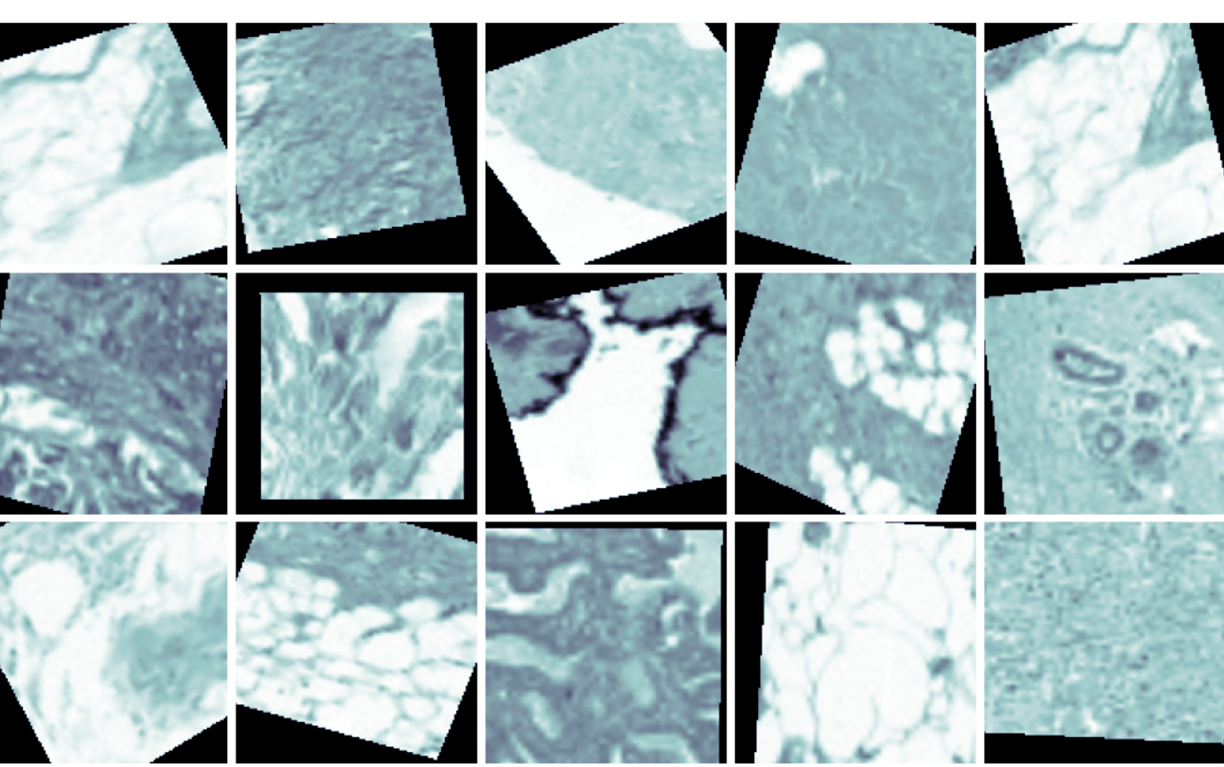
Figure 7. IDC patches with state labels as training samples after preprocessing. 3.3.3. D U-Net Model for Classification 3D U-Net models are a type of DL model which are commonly employed for medical picture segmentation and classification applications. They are developed from the well- known 2D U-Net structure and then further developed to deal with 3D data. Frequently, 3D CNN models are composed of two separate pathways. The first one is the contracting path which consists of convolutional and max pooling layers. The other one is the expand- ing path that includes transposed convolutional and up-sampling layers. The missed links between the contracting and expanding paths in the network allow the spatial information to be preserved from the contracting path. The 3D U-Net model produces a segmentation map or a label for categorizing the data when a 3D data volume is given to it. The model is trained on a larger annotated dataset with the parameters being tuned to minimize a loss function. The model is put through its paces by feeding it an unseen 3D volume and seeing what comes out the other end, a segmentation map and/or a classification label. A 3D U-Net model can have its architecture tailored to the needs of a particular application. The size and capacity of a CNN can be adjusted by tweaking various parameters, such as the number of layers, the number of filters assigned to each layer, the stride value, and the kernel size utilized in each layer. For ductal carcinoma classification, a 3D U-Net model undergoes a training process to distinguish between IDC-positive and IDC-negative re- gions in histopathological images. The entire model is trained using a supervised learning strategy by employing cross-entropy as the loss function. Figure 8 shows the 3D U-Net classifier architecture.